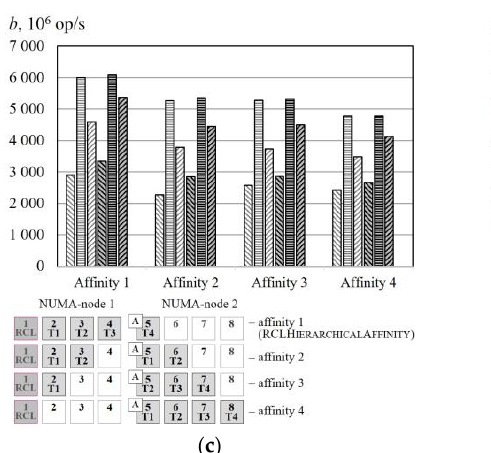
Figure 7. Thread affinity efficiency comparison, Jet cluster (SMP system). ( a ) p = 2; ( b ) p = 3; ( c ) p = 4;